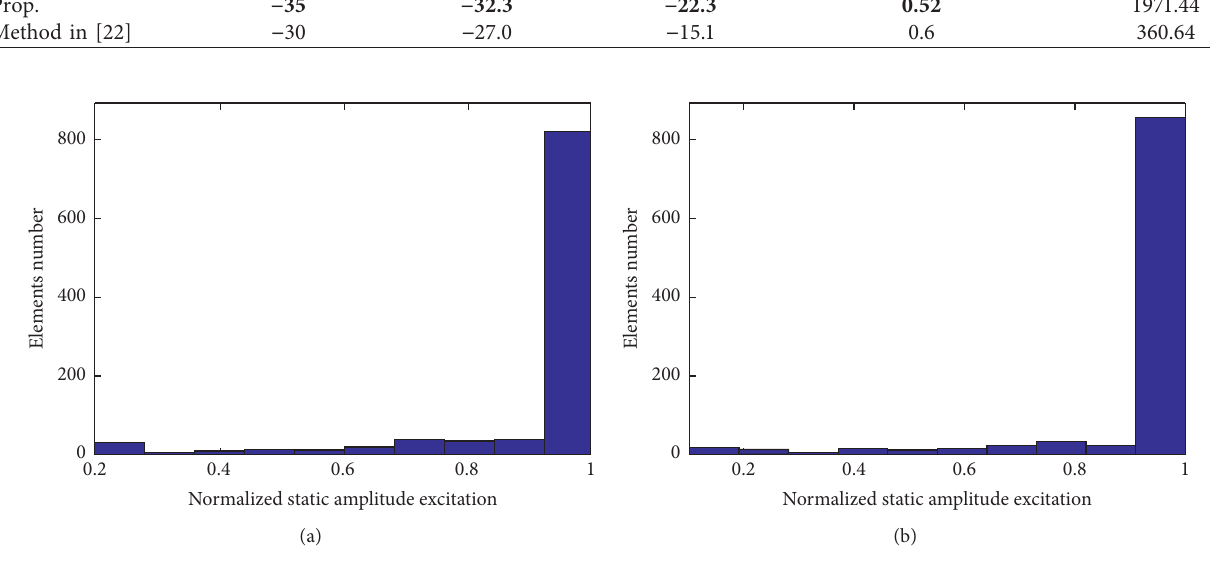
Figure 9: Normalized static amplitude excitation distribution with different DRR. (a) DRR � 5 and (b) DRR �